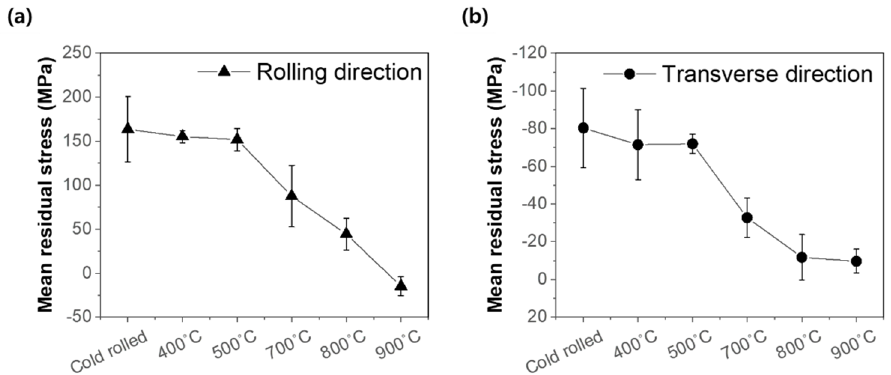
Figure 6. Mean residual stress of the specimens measured along the ( a ) rolling direction and ( b ) transverse direction of the sheet.